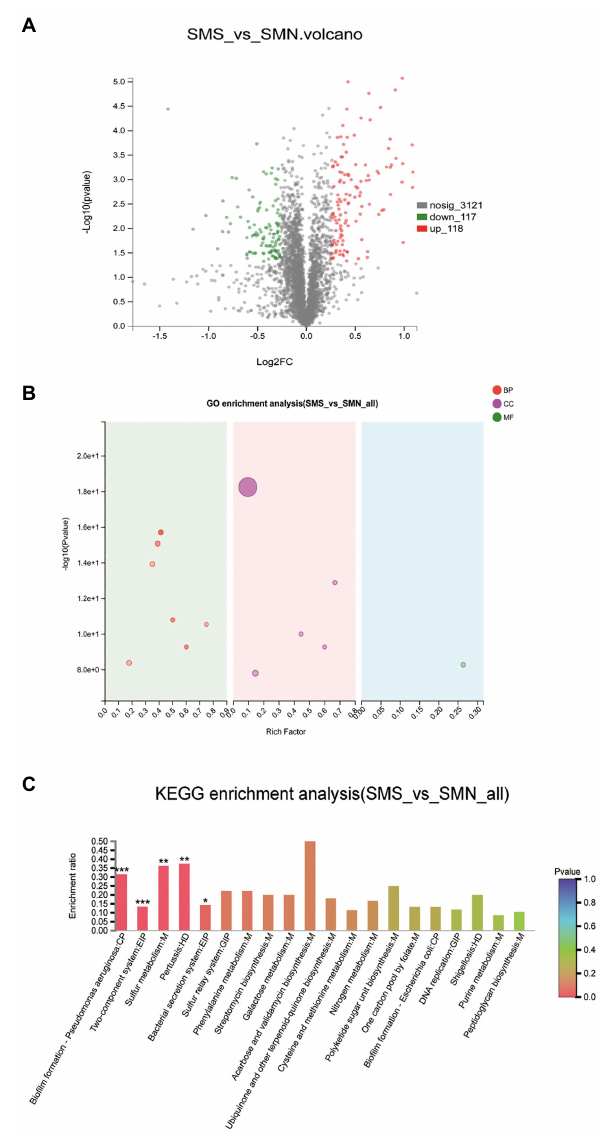
FIGURE 11 | Integration of transcriptomic and proteomic analysis. (A) . The overlapping genes expressed differently in both the transcriptome and proteome. (B) . GO enrichment analysis between up-DEGs and up-DEPs. (C) . KEGG enrichment analysis between up-DEGs and up-DEPs.